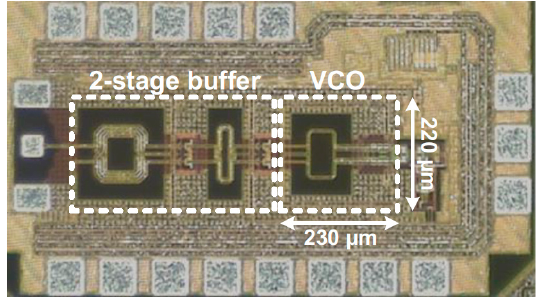
Figure 6. This figure is a die photograph of proposed class-C VCO.